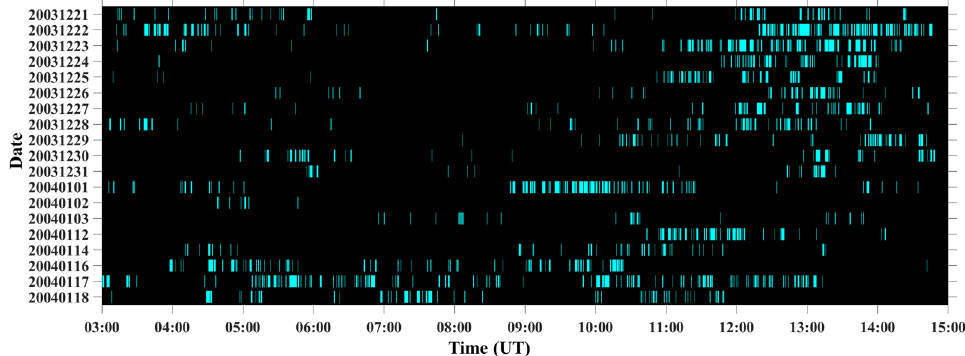
Figure 9. The occurrence time of aurora fold structures detected in D-dataset.